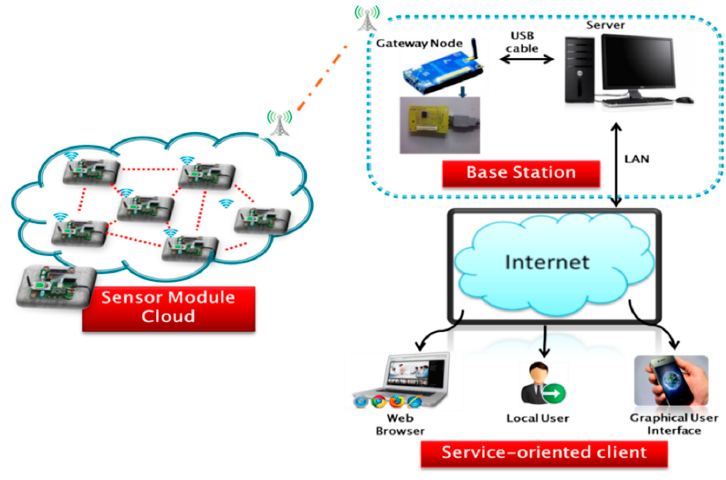
Figure 1. System architecture for real-time indoor air quality (IAQ) monitoring.